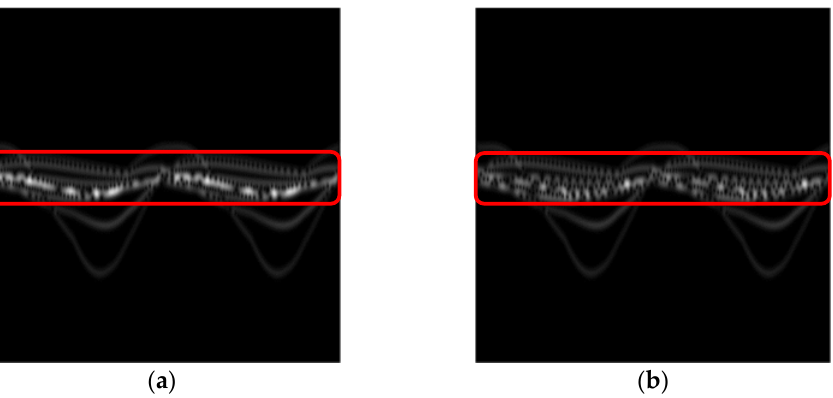
Figure 6. The time–frequency spectrograms of the simulation database based on the modified Boulic model. ( a ) Unarmed pedestrian; ( b ) armed pedestrian. model. ( a ) Unarmed pedestrian; ( b ) armed